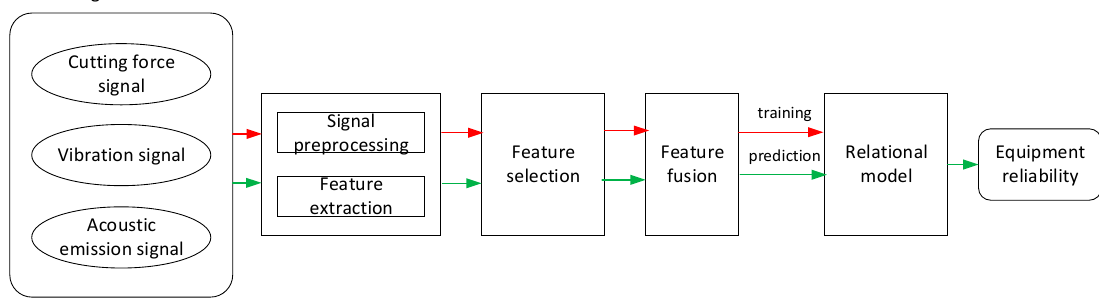
Figure 6. Operational reliability assessment based on artificial intelligence technology.